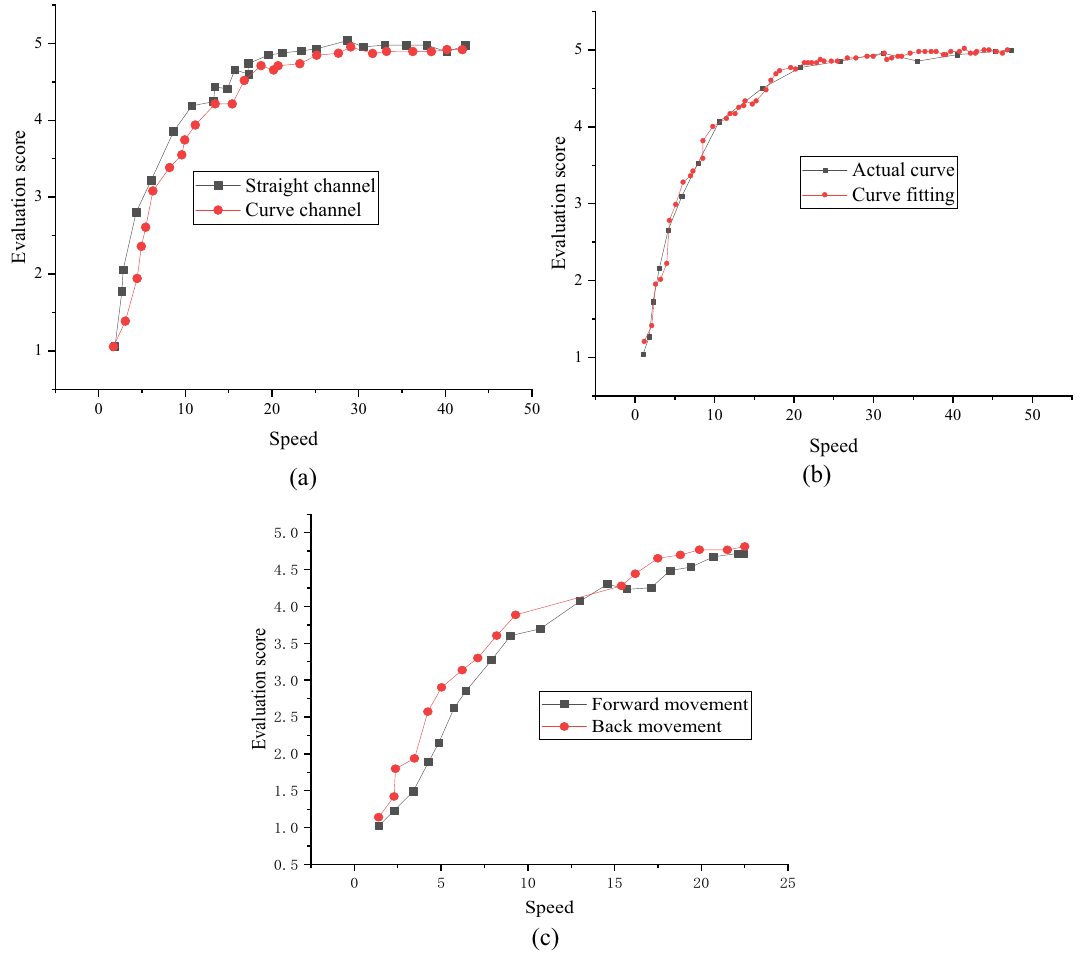
Fig. 4 Dizziness of VR scene moving backward in a straight line ( a comparison results under the straight-line channel and curve channel; b curve fitting results; c comparison of the fitting curves of moving forward and